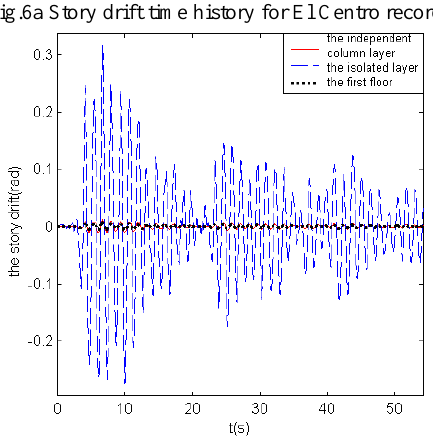
Fig.6b Story drift time history for Taft record Fig.7a and 7b reveal the influence of the